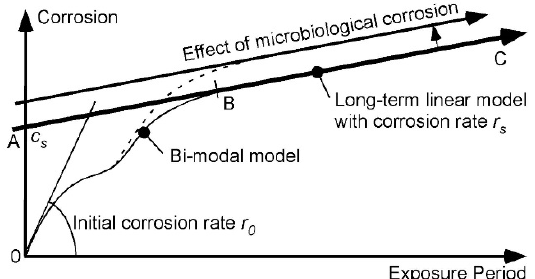
Figure 10. Simplified (linear positive definite) corrosion loss model for long-term corrosion of 90:10 CuNi, showing main effect of nutrient pollution and consequent microbiological corrosion.